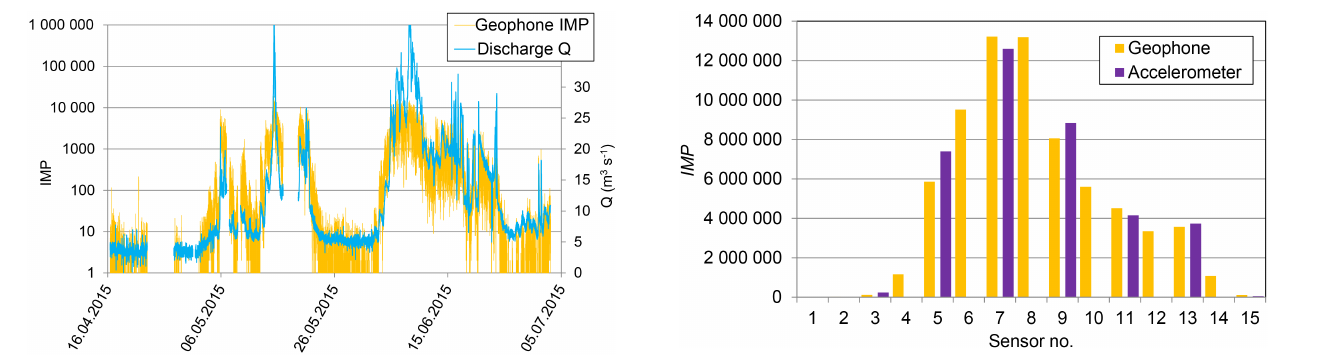
Figure 4. Total sum of impulses (IMP) recorded by each geophone sensor (yellow) and acceleration sensor (violet) during the summer of 2015. The number of impulses recorded by acceleration sensors was scaled according to Eq. (1). The view is in the upstream direc-